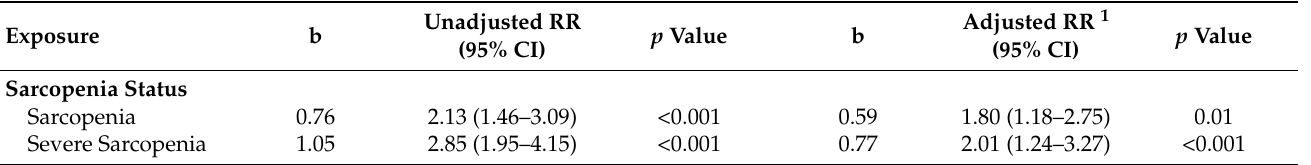
Table 3. GEE analysis showing longitudinal analysis of sarcopenia and severe sarcopenia with cognitive